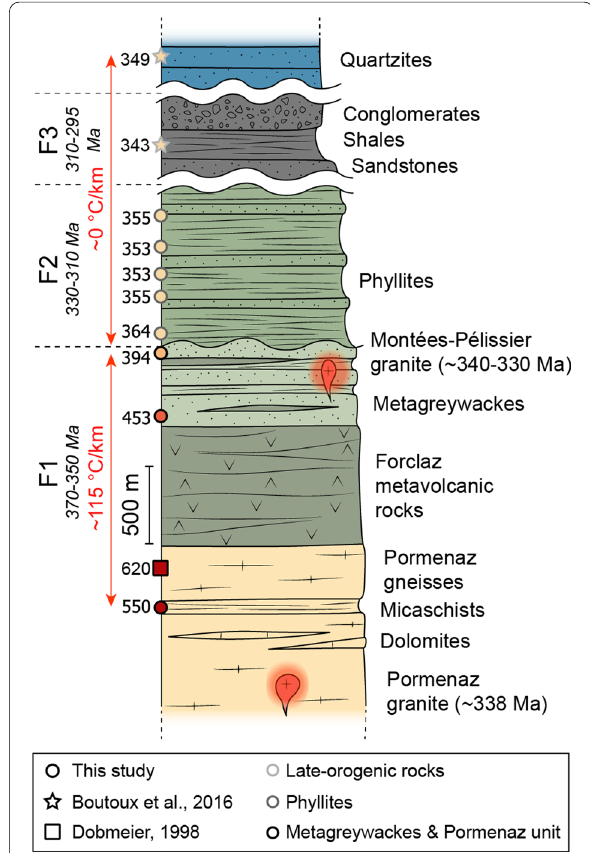
Fig. 9 Stratigraphic Log of the Servoz syncline showing the F1, F2 and F3 formations with representative T RSCM (this study; Boutoux et al., 2016), temperature conditions from Dobmeier (1998) and associated apparent geothermal gradients. Colour of each sample is related to its